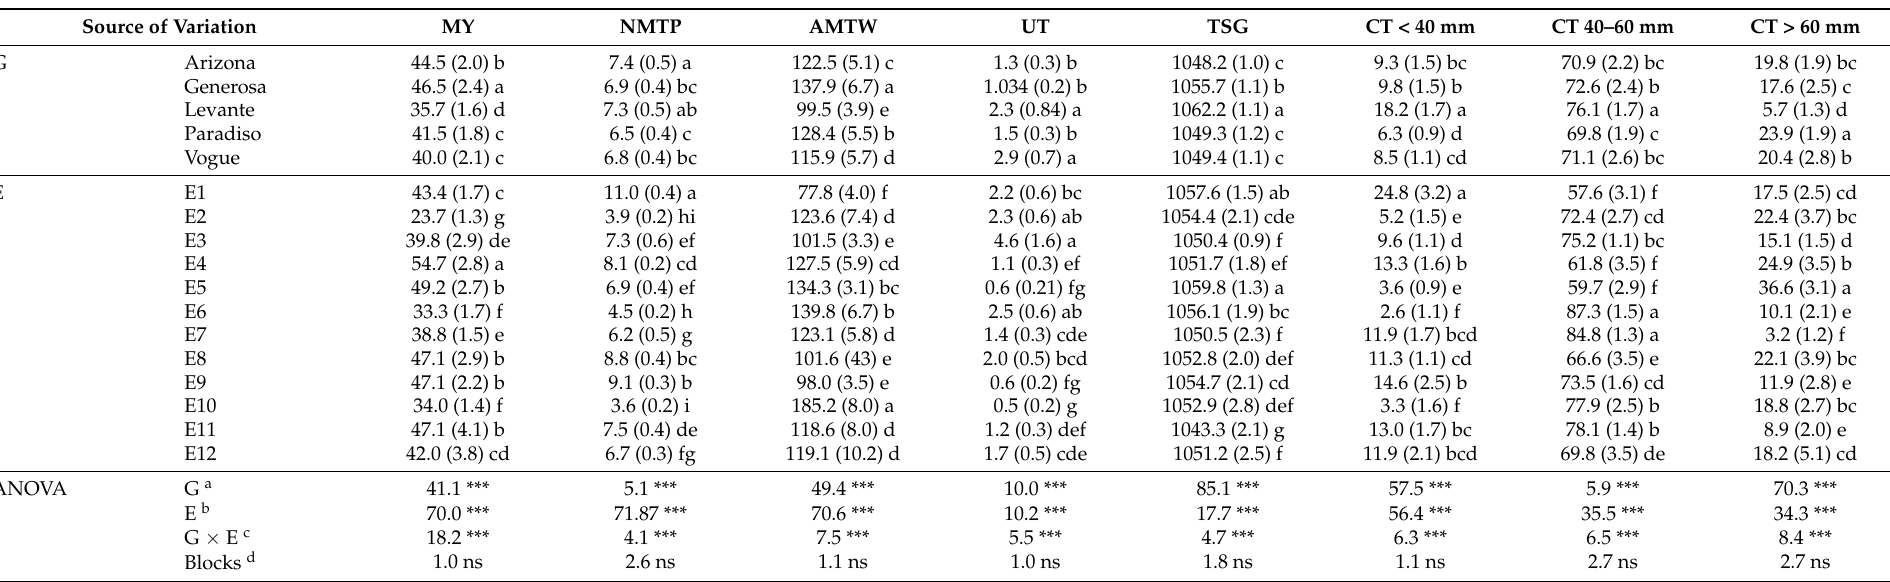
Table 2. Joint analysis of variance (ANOVA, F -values) of five potato genotypes (G) and 12 environments (E) for marketable yield (MY, t ha − 1 ), unmarketable tubers